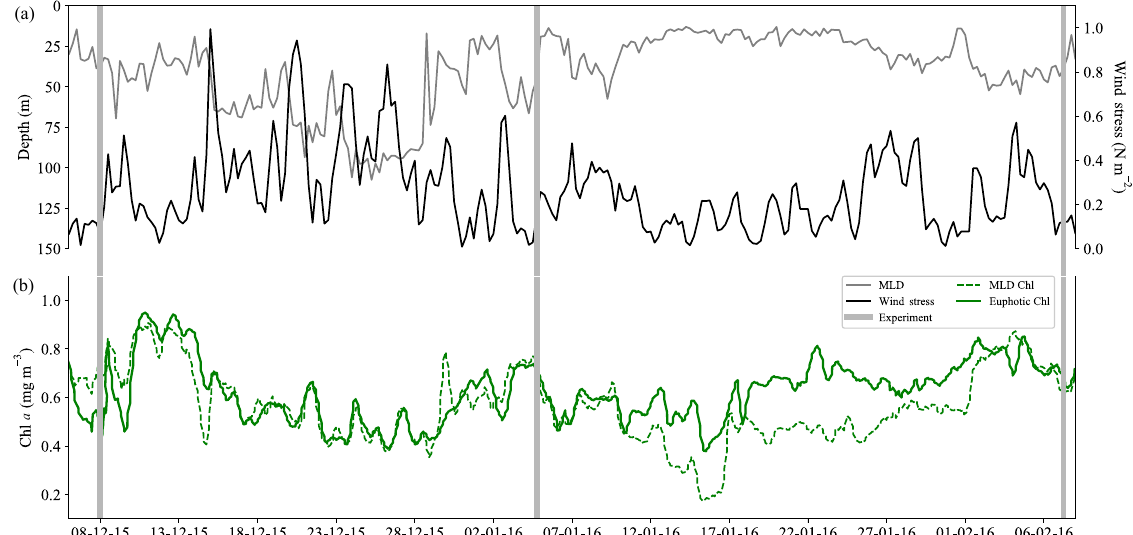
Figure 4. Time series from 6 December 2015 to 8 February 2016 of (a) surface wind stress (Nm − 2 ), mixed-layer depth (MLD; m) where (cid:49)T 10m = 0 . 2 ◦ C, and (b) mean Chl a concentration (mgm − 3 ) from the MLD and the euphotic zone. Experiment initiation dates are overlaid in grey